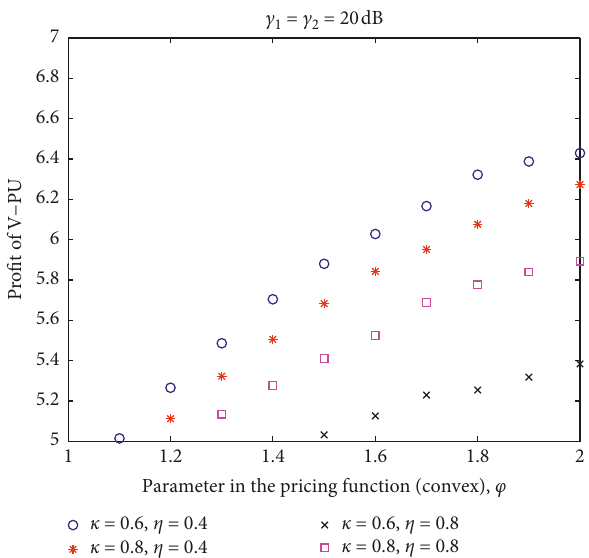
Figure 4: The profit of the V-PU vs. φ on received SNR.